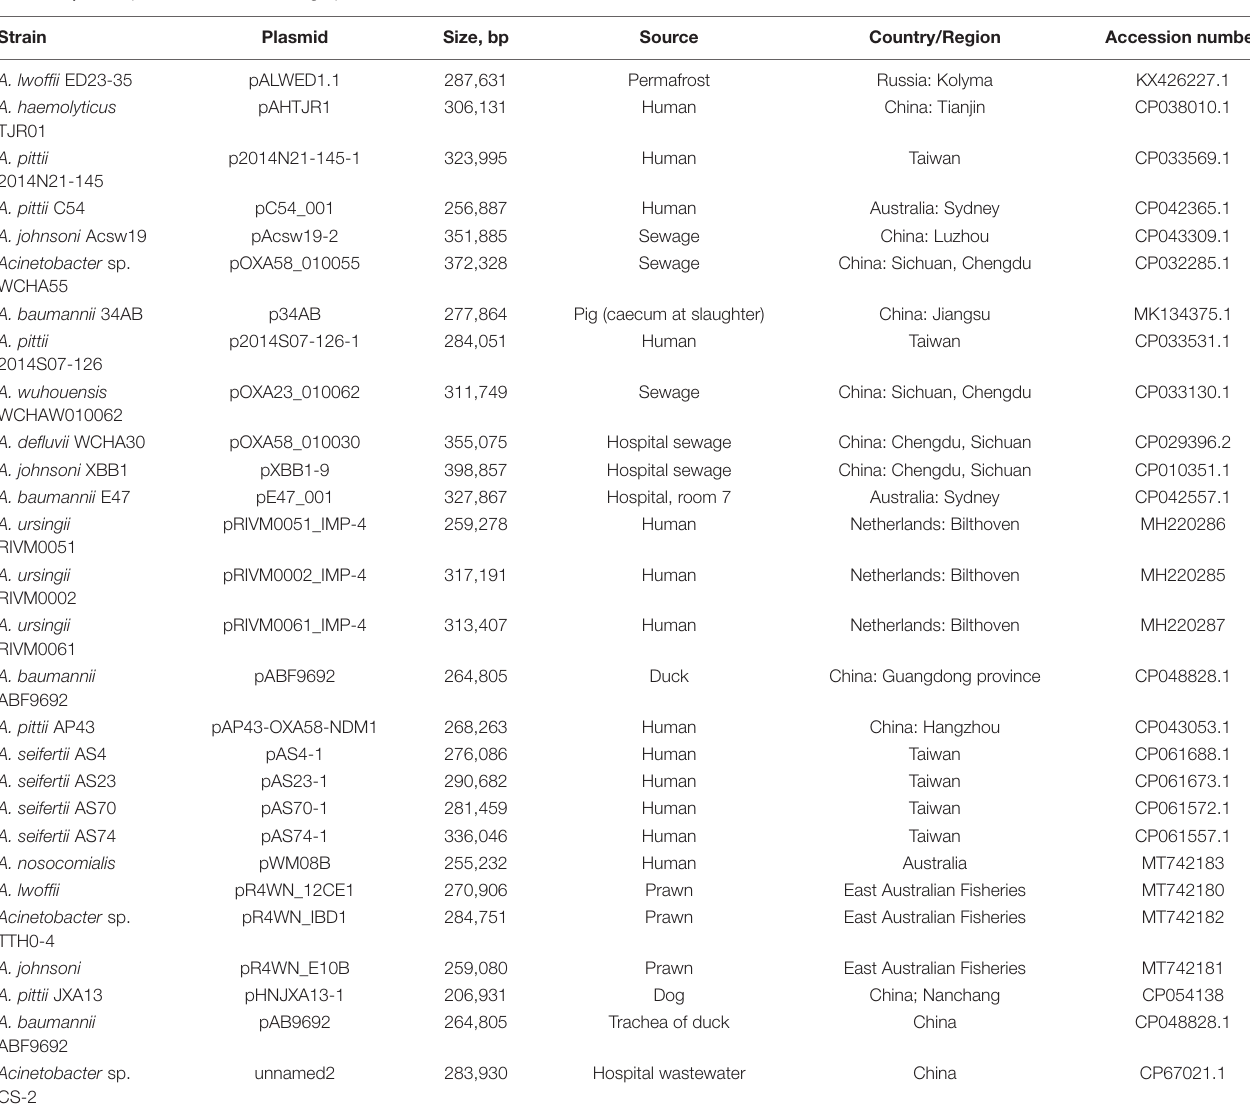
TABLE 3 | List of pALWED1.1-related mega-plasmids.